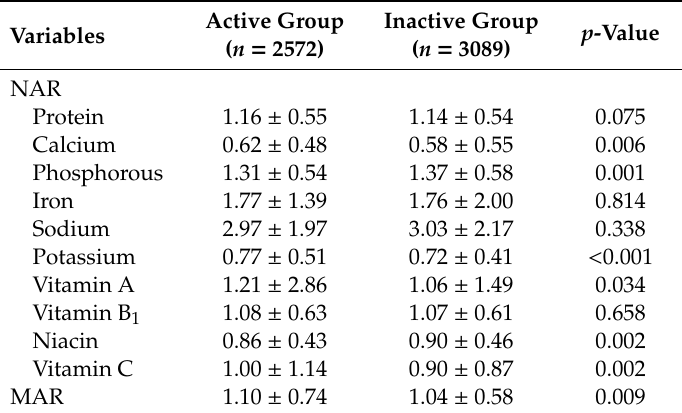
Table 5. Dietary quality according to physical